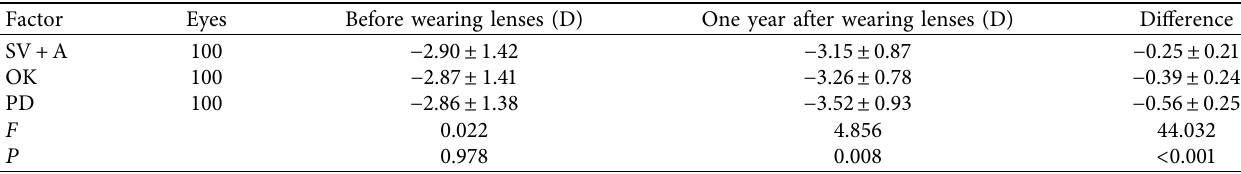
Table 2: Comparison of spherical equivalent before and after wearing lenses between the SV+A, OK, and PD groups. Factor